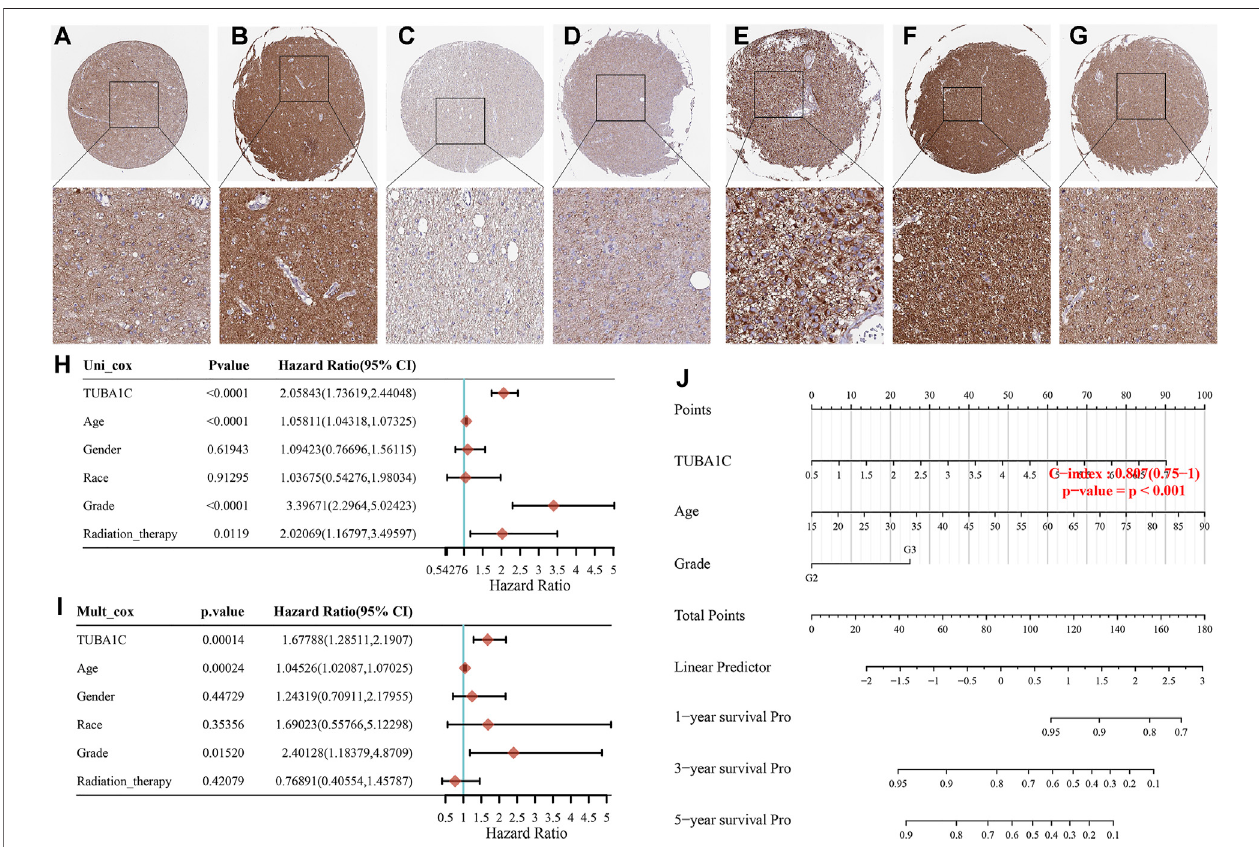
FIGURE 2 | The TUBA1C expression detected by immunohistochemistry and the construction of prognostic signature in LGG. Representative immumohistochemical stainings in various normal (A) , LGG (B – D) and GBM (E – G) tissues. Hazard ratio and p -value of constituents involved in the univariable (H) and multivariate (I) Cox regression. (J) Nomogram consisting of risk score and other clinical indicators to predict the 1-yr, 3-yr and 5-yr OS of the patients with